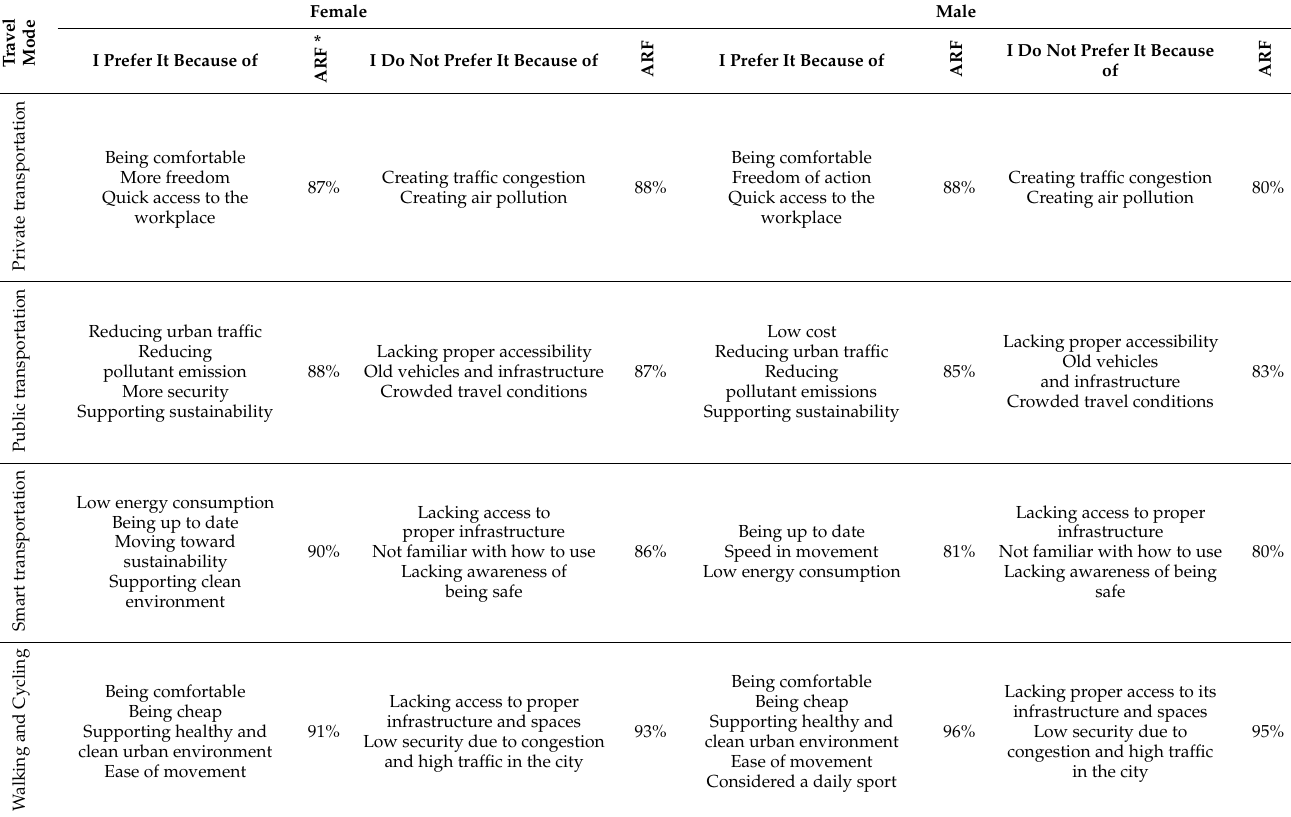
Table 8. Travel mode preferences between males and females in the Tehran metropolitan